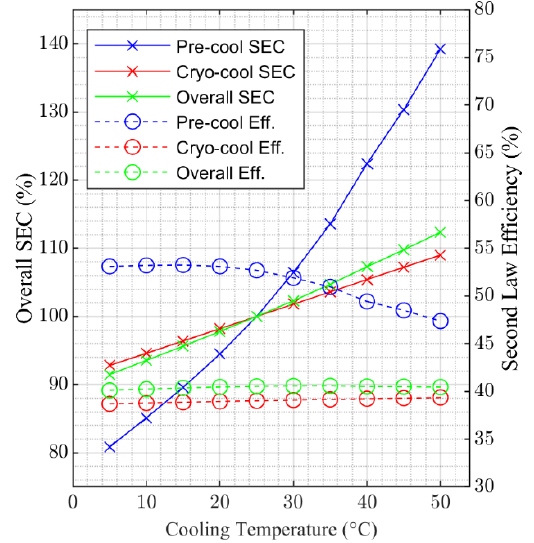
Figure 9. Percentage variation in overall SEC and second law efficiency for the pre-cooling, cryo- genic-cooling and overall cooling processes.